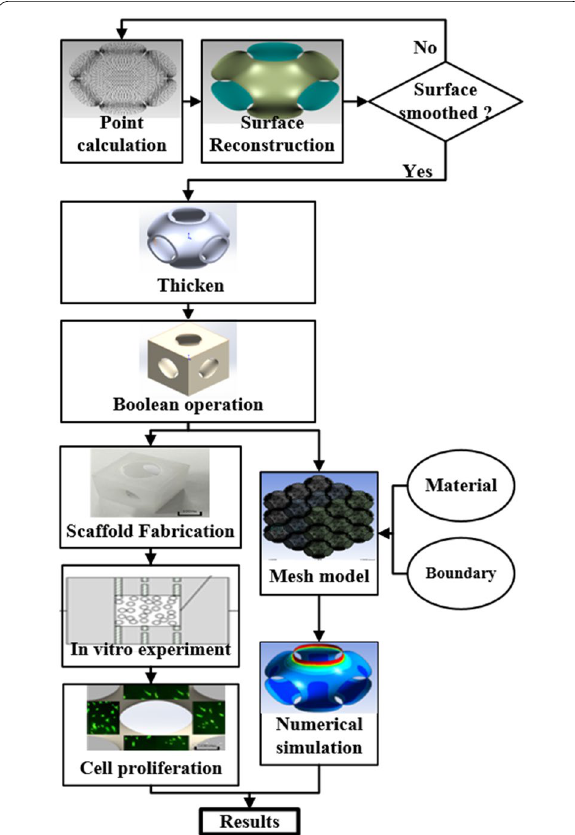
Figure 7 General flowchart of this study Table 1 Geometry details of the single-unit model Pore diameter (μm)